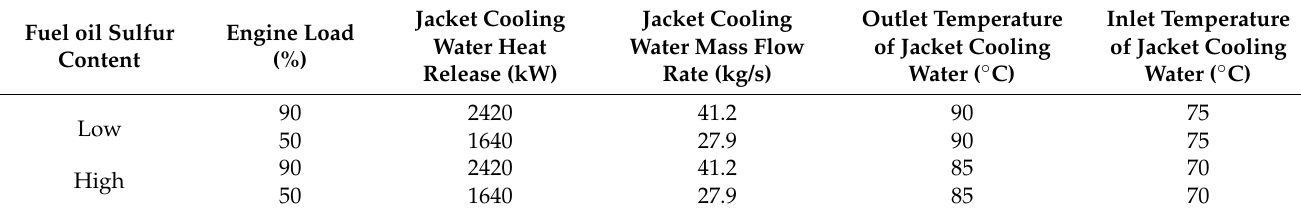
Table 4. Jacket cooling water